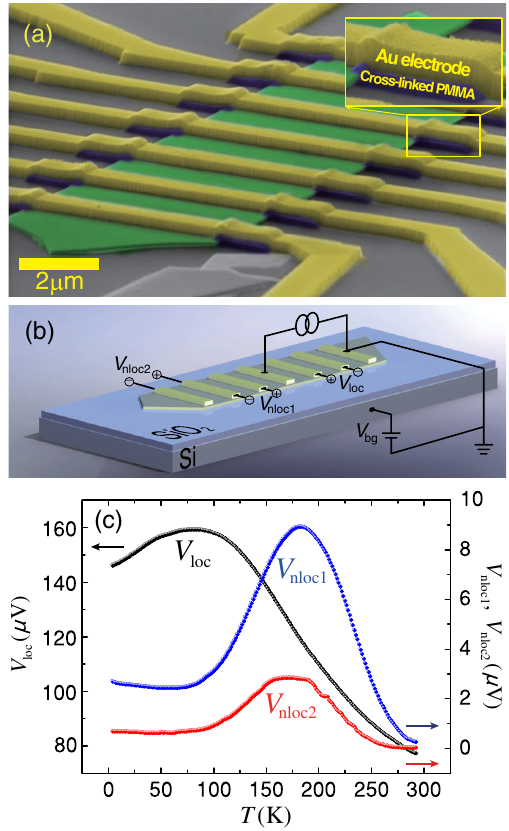
FIG. 1. (a) Scanning-electron-microscopy image of our BSTS thin flake, with Ti/Au ( 10 nm = 300 nm thick) electrodes. The dark-blue regions under the Au electrodes (see the magnified view in the inset) are cross-linked PMMA insulating layers, which prevent shorting between the Au electrodes and the BSTS flake. The scale bar is 2 μ m in length. The sample dimensions are summarized in Table I. (b) Schematic diagram of the measure- ment configuration. (c) Temperature dependence of V (black loc line), V (blue line), and V (red line). nloc 1 nloc 2